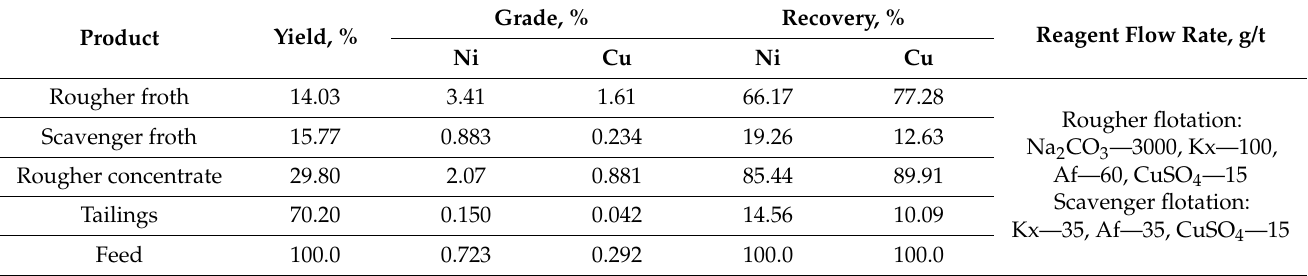
Table 1. Flotation performance of the copper–nickel